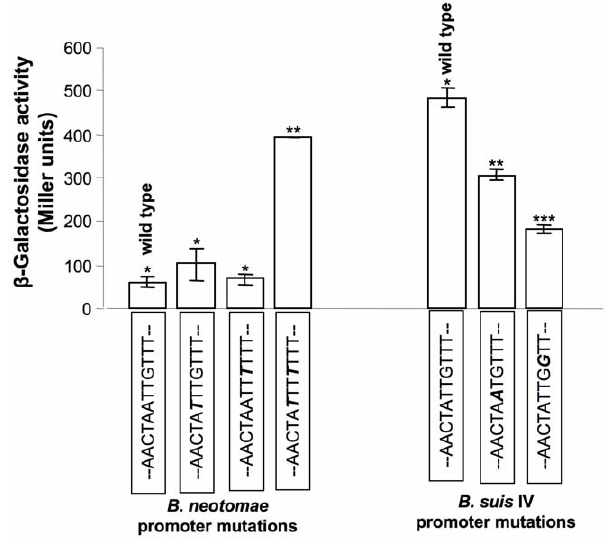
Figure 7. b -Galactosidase activity in B.neotomae transformed with plasmids containing lacZ gene under the control of wildtype and the indicated mutated B.neotomae and B.suis biovar 4 (strain 40) sodC promoters. For each promoter construct, the assays were performed using 3 separate colony cultures. Results are shown as the mean 6 standard deviation of Miller units. In each panel, means with the same number of asterisks were not significantly different from each other ( P . 0.05), but there were significant differences between means with different number of asterisks ( P ,